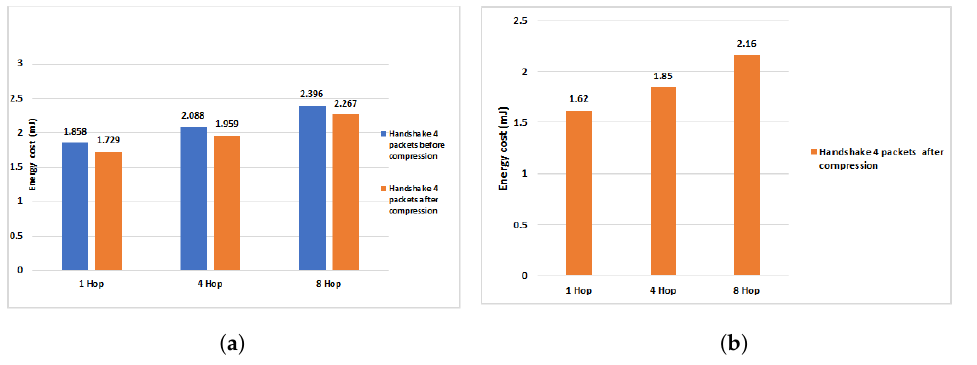
Figure 12. Energy communication costs of HIP DEX handshake (4 packets). ( a ): Calculation done according to results obtained in [9]. ( b ): Results obtained with LC-DEX.